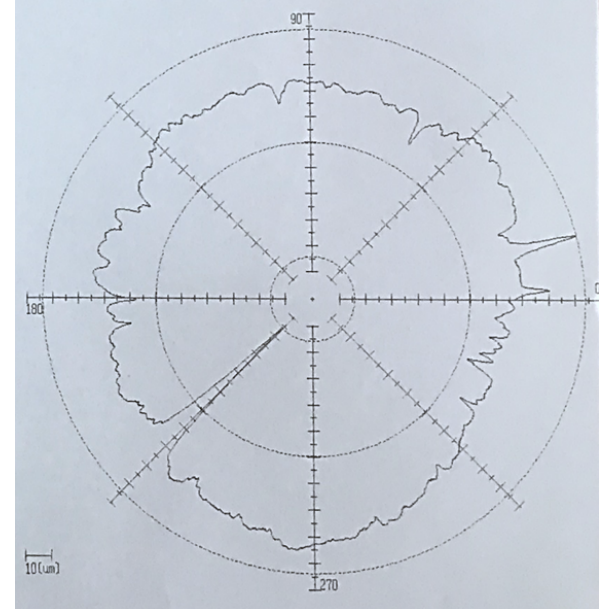
Figure 16: Display of circularity deviation for diameter